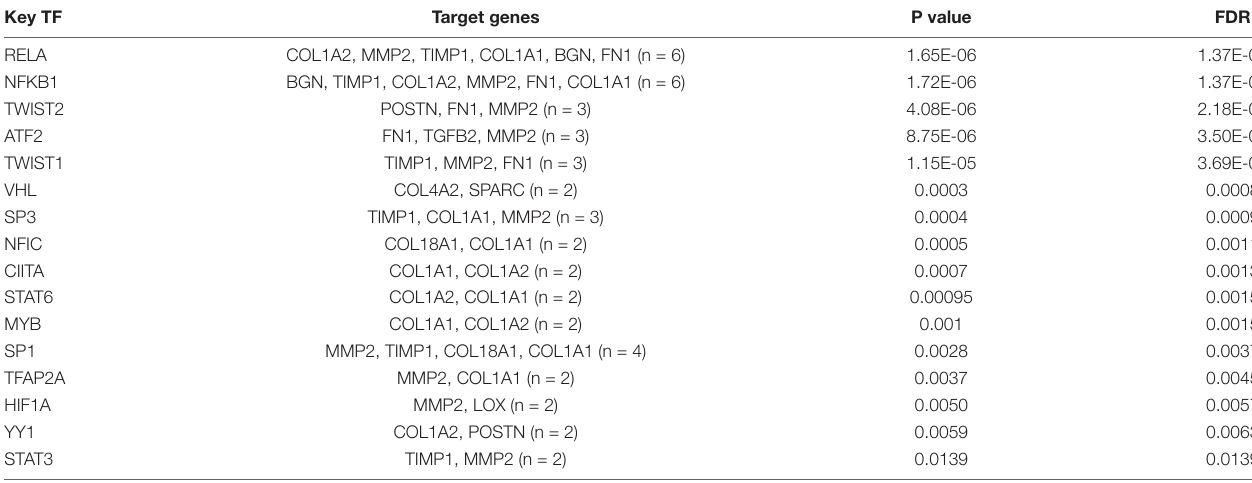
TABLE 2 | Key transcription regulators (TF) targeting the 25 ARVC hub genes.